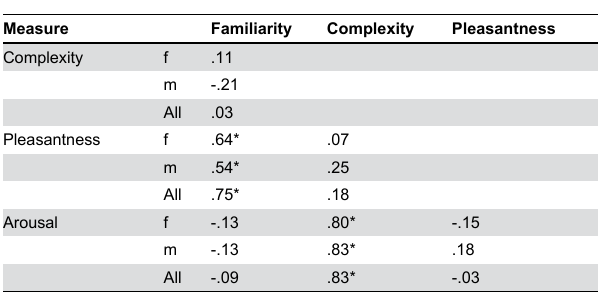
Table 9. Spearman’s rank-order correlations between ratings of familiarity, complexity, pleasantness and arousal of piano solo music excerpts (N 85).